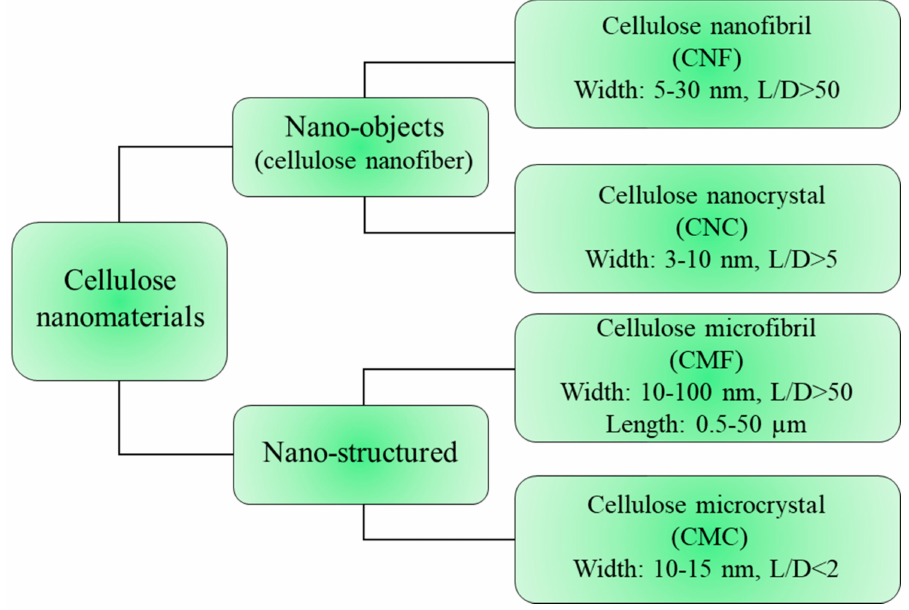
Figure 3. Classification of cellulose nanomaterials based on size and appearance.